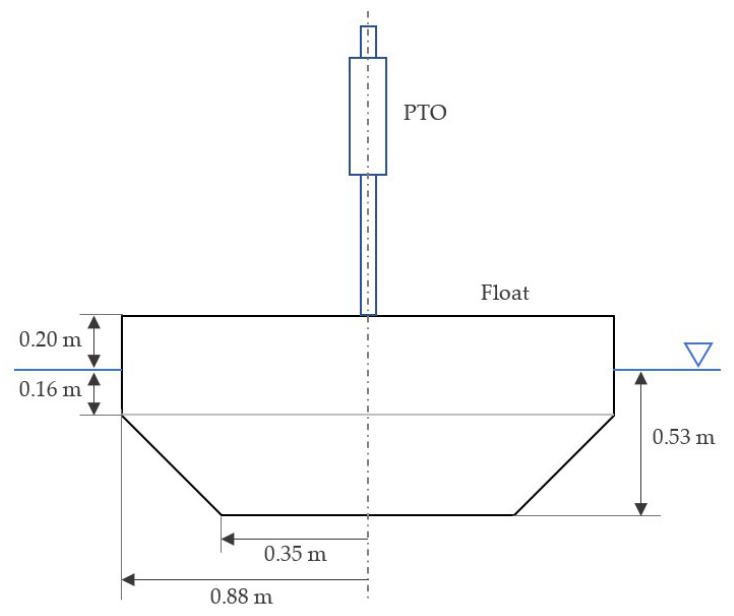
Table 1. Model-scale wave energy converter (WEC) physical parameters.